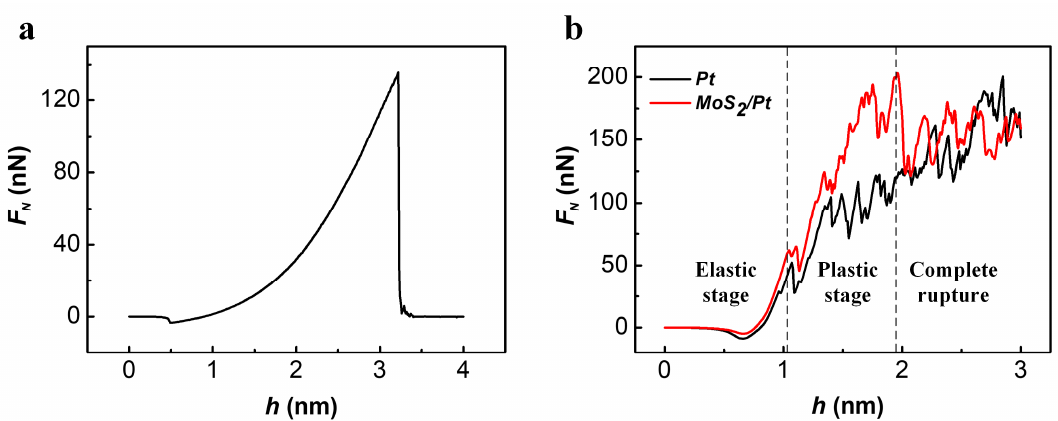
Figure 2. ( a ) The force-displacement curve for the indentation process of the freestanding MoS 2 monolayer; ( b ) The force-height curve for the indentation process of bare Pt and MoS 2 /Pt substrate.